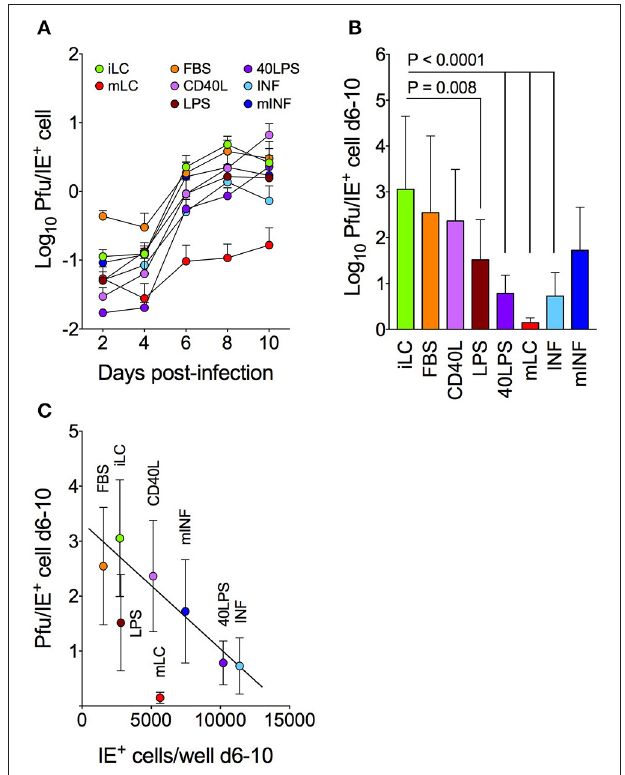
FIGURE 2 | Progeny production efficiencies inversely correlate with the number of infected cells present at late times post-infection. Immature and activated LC were infected with TB40/E at an MOI of 10, and the amount of progeny per IE + cell released in the supernatant during the entire time course (A) and at peak times (days 6–10, B ) was calculated. The median number of pfu/IE + cell was then plotted against the median number of cells expressing the IE proteins in each well at the same time (C) . The best-fitting line modeling the relationship between the X and Y values of all data points except those of mLC and LPS cultures was identified by linear regression ( Y = –0.0002 X + 3.3, R 2 = 0.92). Symbols represent the median and median absolute deviation values of data collected with LC derived from six different CD34 + cell donors in eight independent experiments, and from three donors in two independent experiments (40LPS condition). The P -values for pairwise comparisons of data distributions using the KS test are